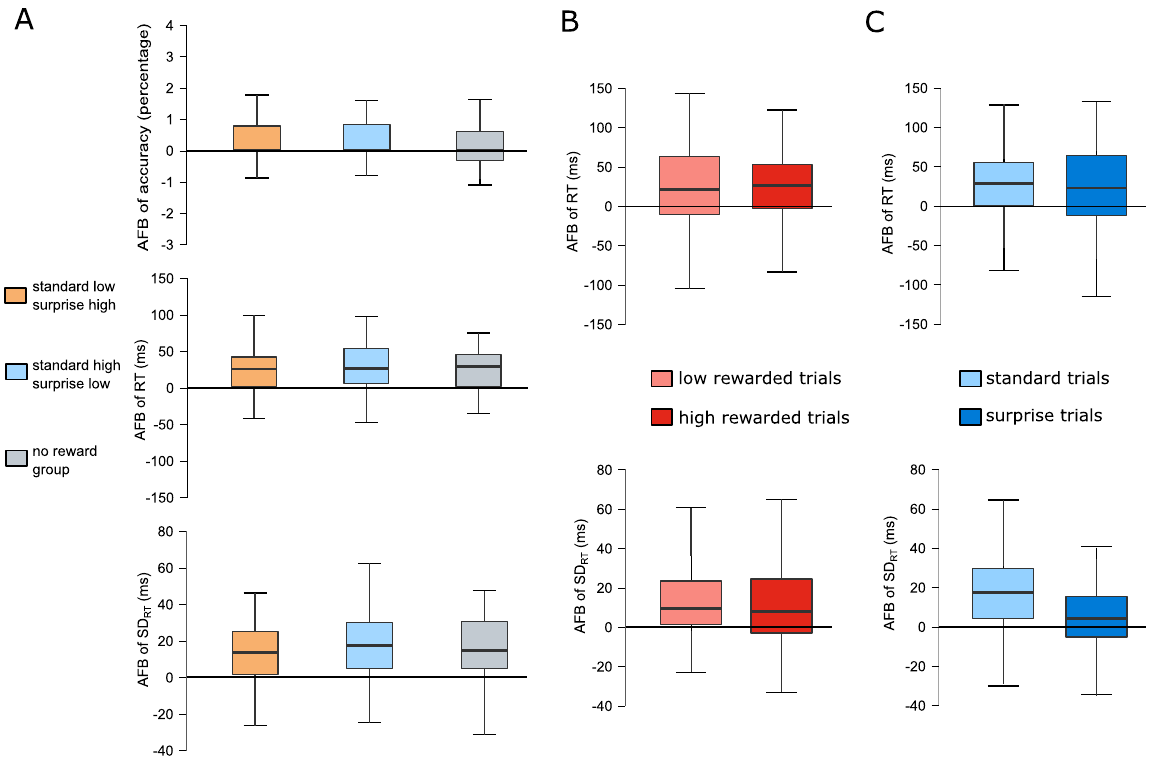
Figure 3. Boxplots depicting action file binding (AFB, i.e., feature overlap minus no feature overlap) for accuracy (hits in %), mean RT in ms and standard deviation of RT in ms (SD RT ) data. ( A ) Comparison of standard low—surprise high, standard high—surprise low and no reward group for accuracy, RT, and SD RT . ( B ) Low (bright red) vs high (dark red) reward condition for RT and SD RT since they showed significant main effects of feature overlap. ( C ) Standard (bright blue) vs surprise (dark blue) condition for RT and SD RT since they showed significant main effects of feature